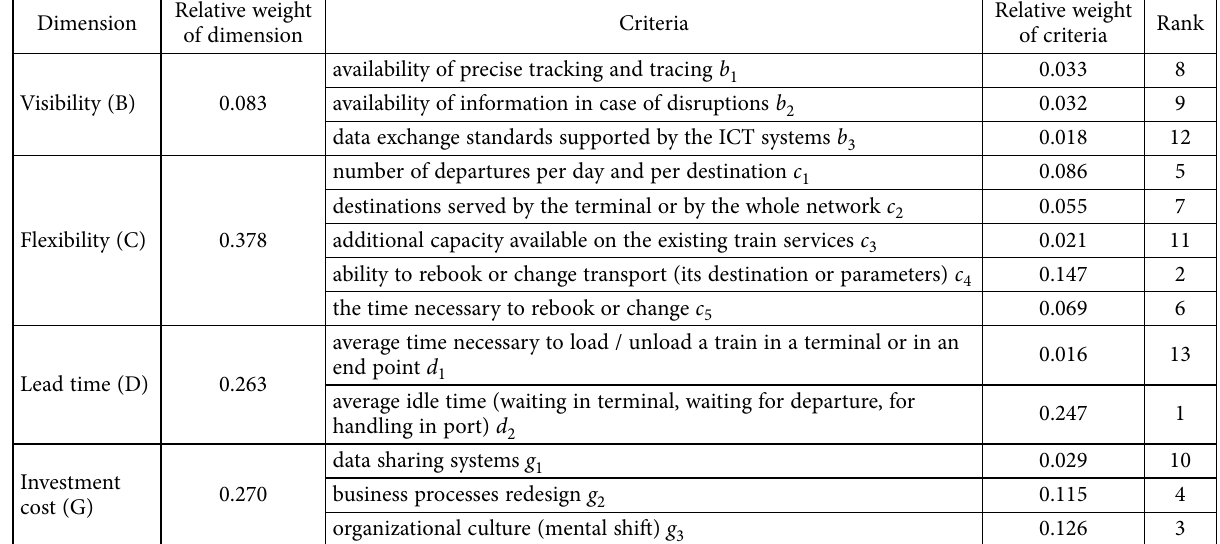
Table 6. Influential weights of DEMATEL–ANP for each criterion obtained by